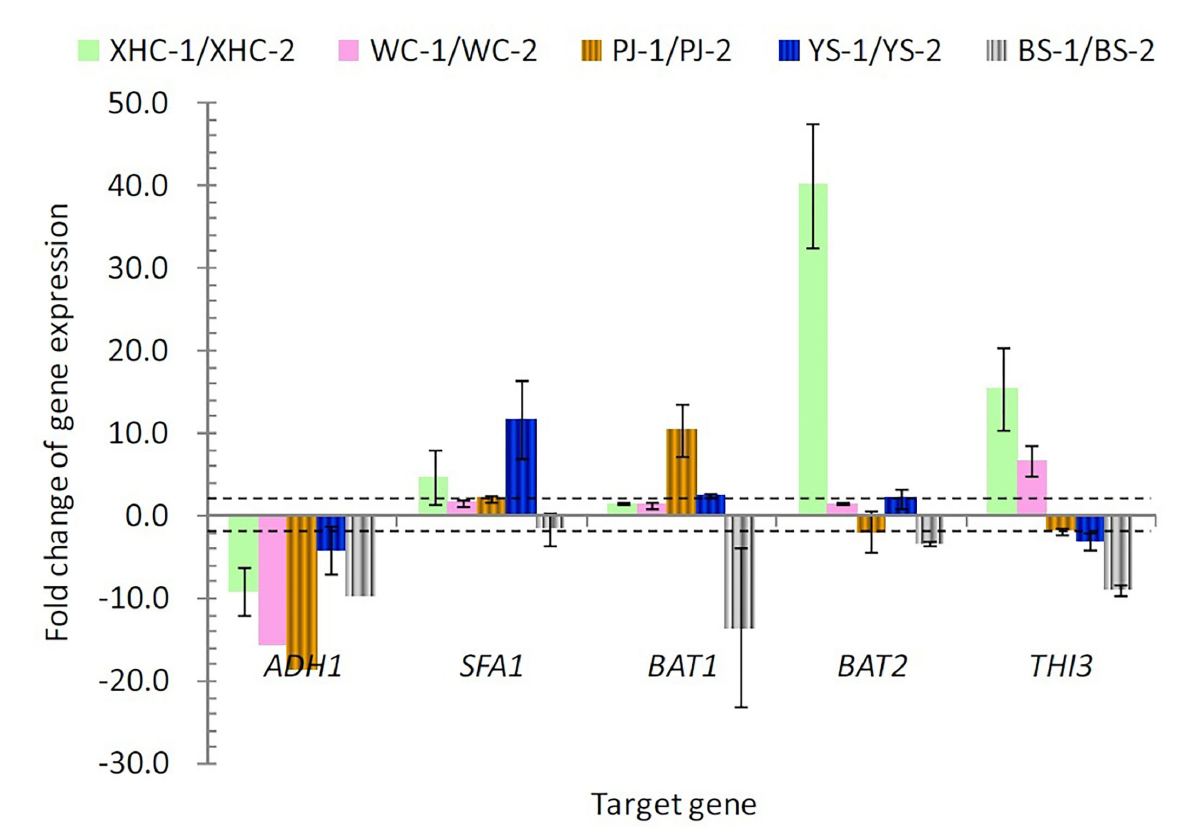
FIGURE3 The expression change in five target genes between the middle and end of fermentation. The dotted lines denote the fold change exceeding two. 1 and 2 denote the middle and end point of